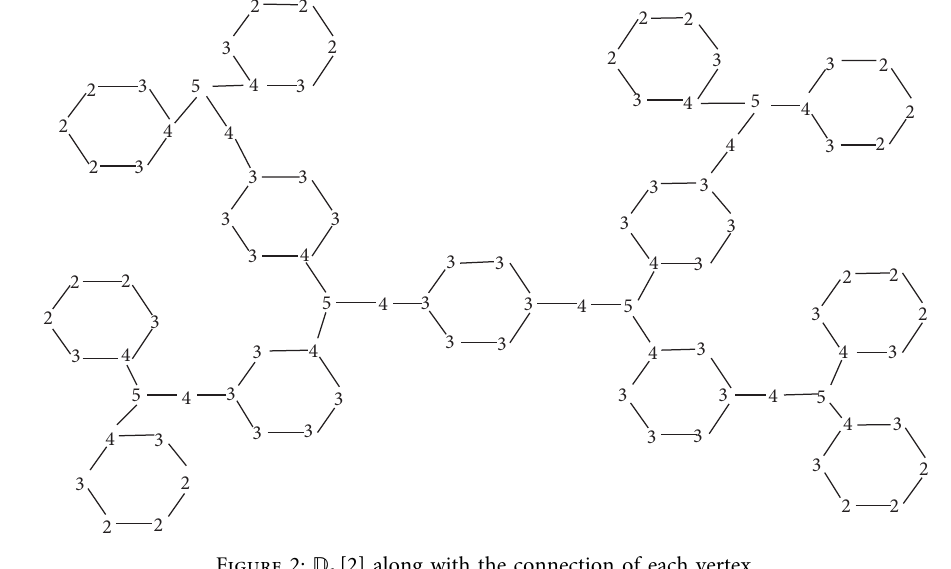
Figure 2: D [ 2 ] along with the connection of each vertex. 1